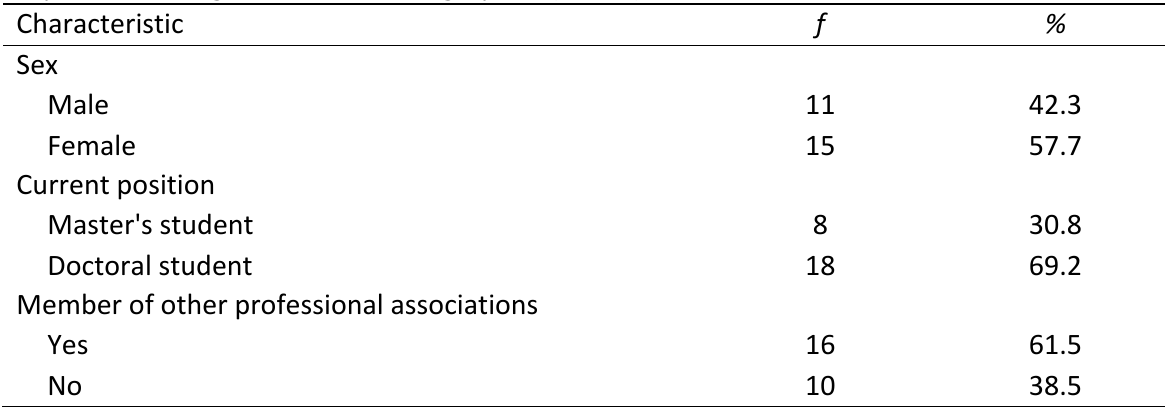
Respondent Backgrounds and Demographics (n =